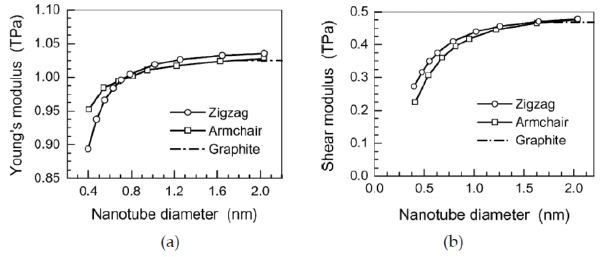
Figure 3. ( a ) Young’s moduli and ( b ) shear moduli of carbon nanotubes versus tube diameter. Adapted with permission for [100], copyright Elsevier,